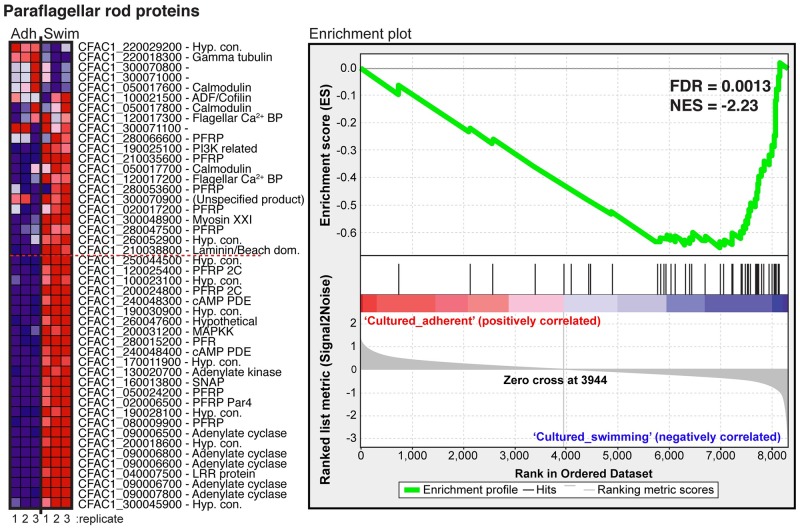
GSEA of putative paraflagellar rod proteins.The left panel shows a heat map of enrichment in adherent (Adh) or swimming (Swim) forms for the three individual replicates (bottom of image). Gene identifiers and TriTrypDB gene name are shown. Red color indicates transcript enrichment in swimming form and blue indicates enrichment in adherent form. The 25 genes below the red dashed line (GSEA software threshold) are considered as significantly contributing to the enrichment of the set. The right panel shows the enrichment plot generated by the GSEA software with the Normalized Enrichment Score (NES) and False Discovery Rate (FDR) indicated for this gene set. A negative NES indicates enrichment in swimmers. The gray shaded area shows a rank order of the genes based on their enrichment in adherent (left, red) or swimming forms (right, blue). The black vertical lines indicate the position of the 46 members of the set within the rank order. The density of lines on the right indicates the strong enrichment of genes in swimming form. The green line indicates the enrichment profile generated by the software.